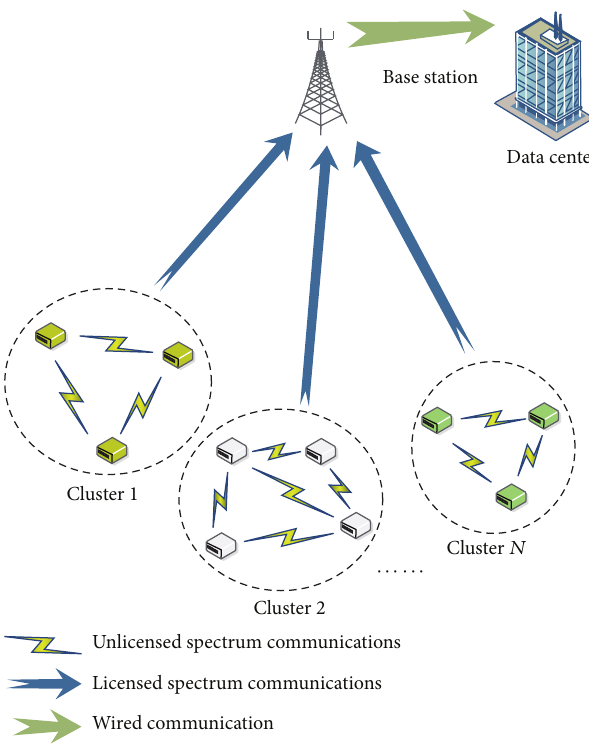
Figure 1: An illustration of system